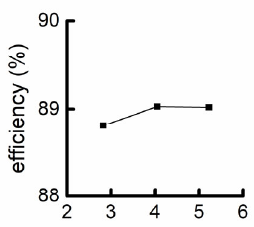
Figure 12. Mesh convergence verification (different mesh numbers). ( a ) Efficiency ( b ) Total pressure ratio ( c ) Steady static pressure at 50% blade span.